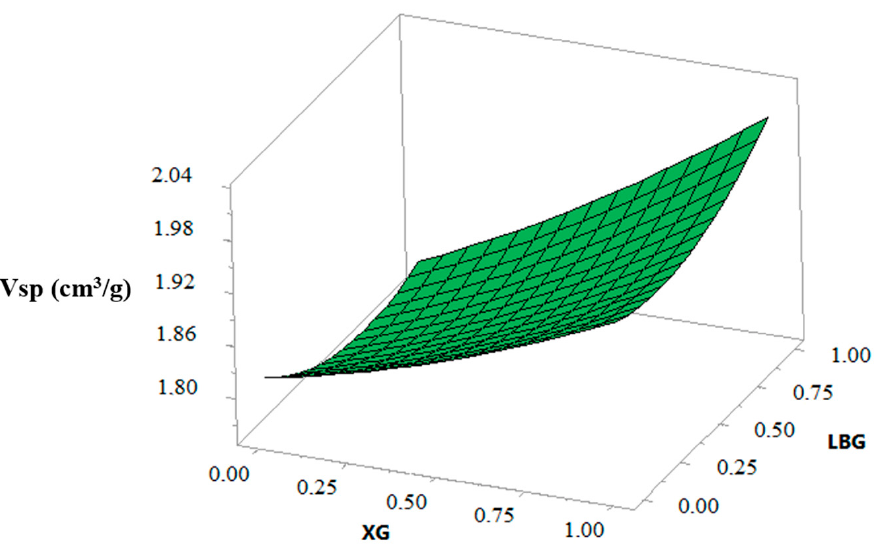
Figure 4. Response surface showing the effect of xanthan gum (XG) and locust bean gum (LBG) on the specific volume (Vsp) of biscuits.